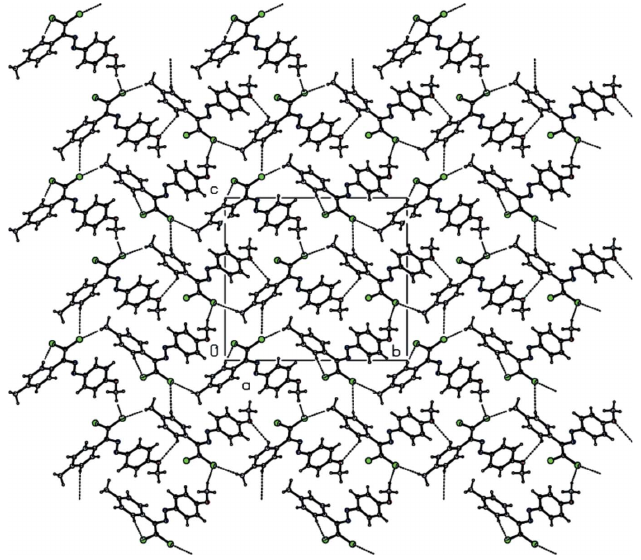
interactions [Table 2, Fig. 3; C5—H5 A (cid:2) (cid:2) (cid:2) Cg 2 i , C23—